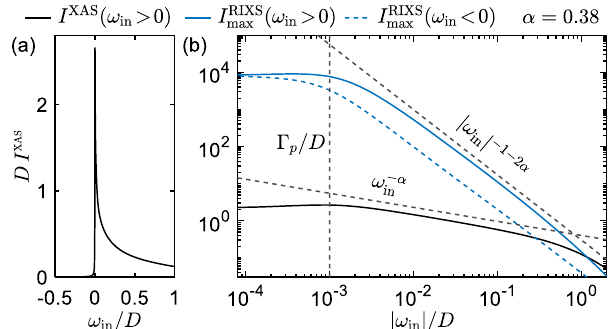
FIG. 8. XAS spectrum I XAS ð ω (black lines) for the MIM in Þ =D ¼ 0 . 5 , T=D ¼ 10 − 5 , Γ =D ¼ 10 − 3 ), using (a) linear and ( U p p observed for (b) logarithmic scales. The power law I XAS ∼ ω − α in Γ ≲ ω ≲ D quantitatively matches the prediction of Eq. (98). p in ω For comparison, (b) also shows the RIXS maximum I RIXS max ð in Þ ¼ max ω ½ I RIXS ð ω in ; ω loss Þ(cid:2) (blue lines, solid and dashed), diverging loss − 1 − 2 α . Here, ϵ merely shifts much more strongly as ∼ j ω p in j ≃ − 0 . 33 D þ j ϵ ≫ D , without changing I XAS and I RIXS as ω p j th a function of ω or ω in loss